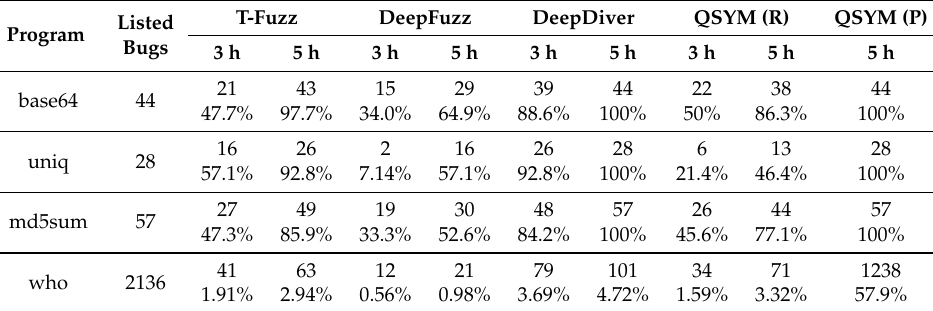
Table 2. The number of found bugs in testing on LAVA-M dataset.